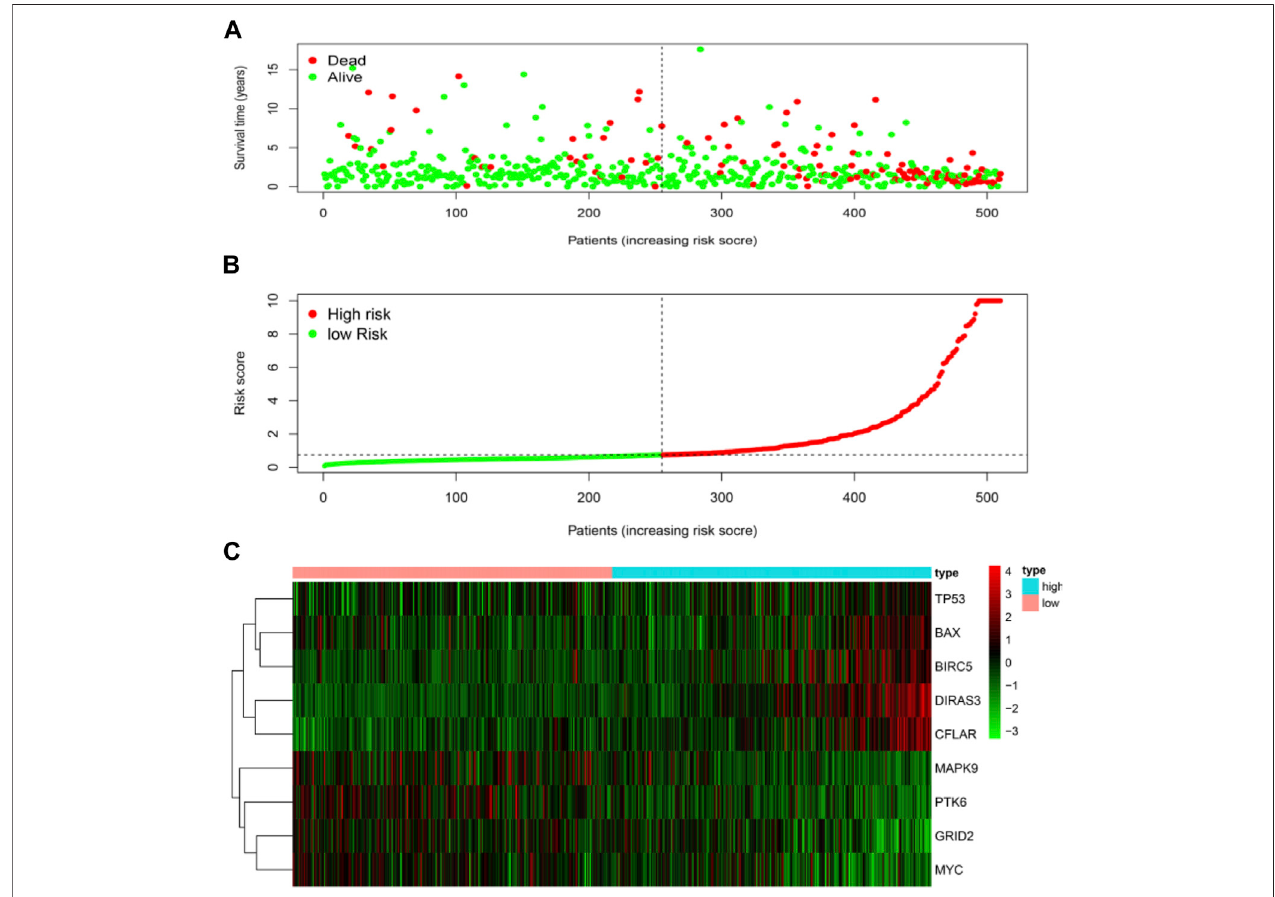
FIGURE 4 | Risk score analyses of high and low-risk groups in tumor patients. (A) risk score scatters plot of high risk and low risk. Red dots represented the dead patientsandgreenrepresentedthealive.Withtheincreaseinriskscores,morepatientsdied. (B) dottedlineindicatestheindividualin fl ectionpointoftheriskscorecurve, by which thepatientswere categorized into low-risk and high-risk groups. LGG patientswere presented asred point (high-risk)and green point (low-risk). (C) riskscore heatmap of nine ARGs. The colors from green to red indicate the expression level of genes varies from low to high.